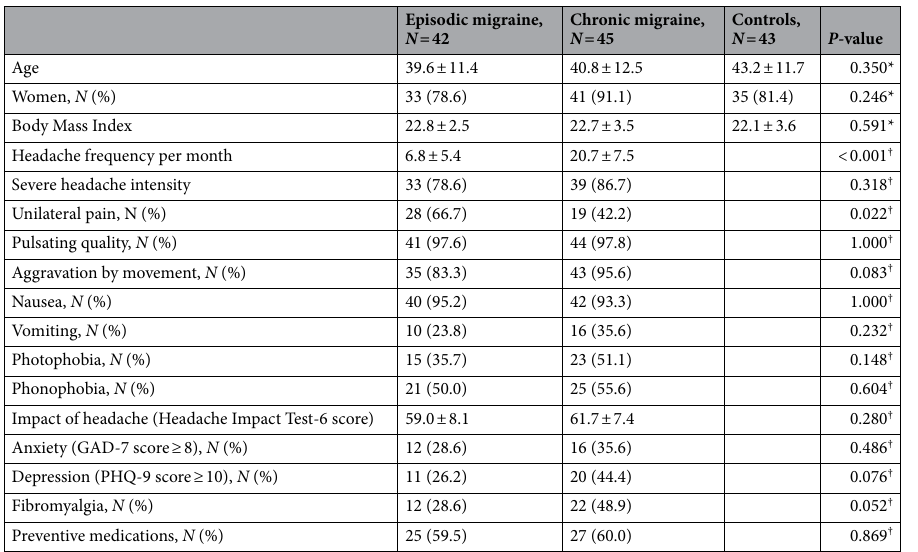
Table 1. Demographic and clinical characteristics of participants with episodic and chronic migraine and the control. EM episodic migraine, CM chronic migraine. *Compared among participants in the EM, CM, and control groups. † Compared between participants with EM and